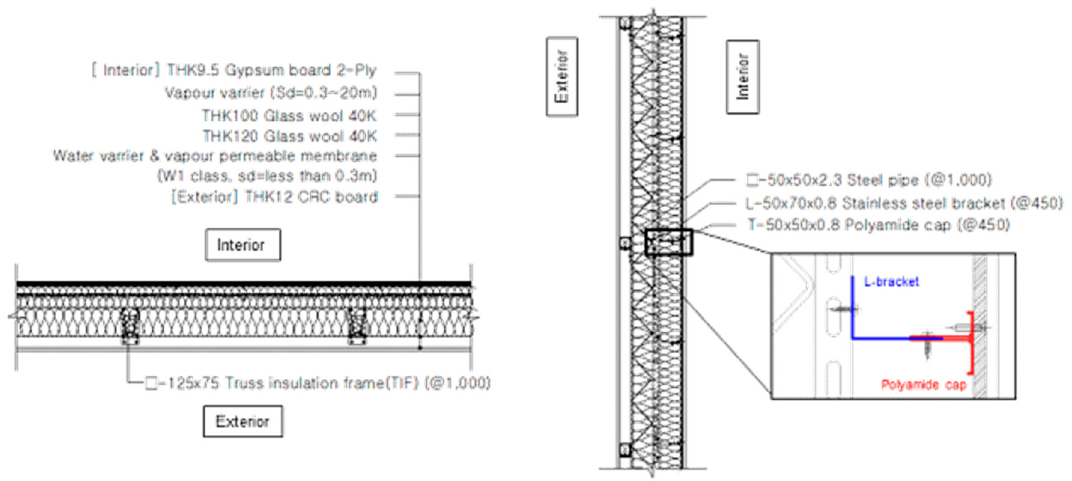
Figure 2. Configuration of the dry exterior insulation system using TIFs.